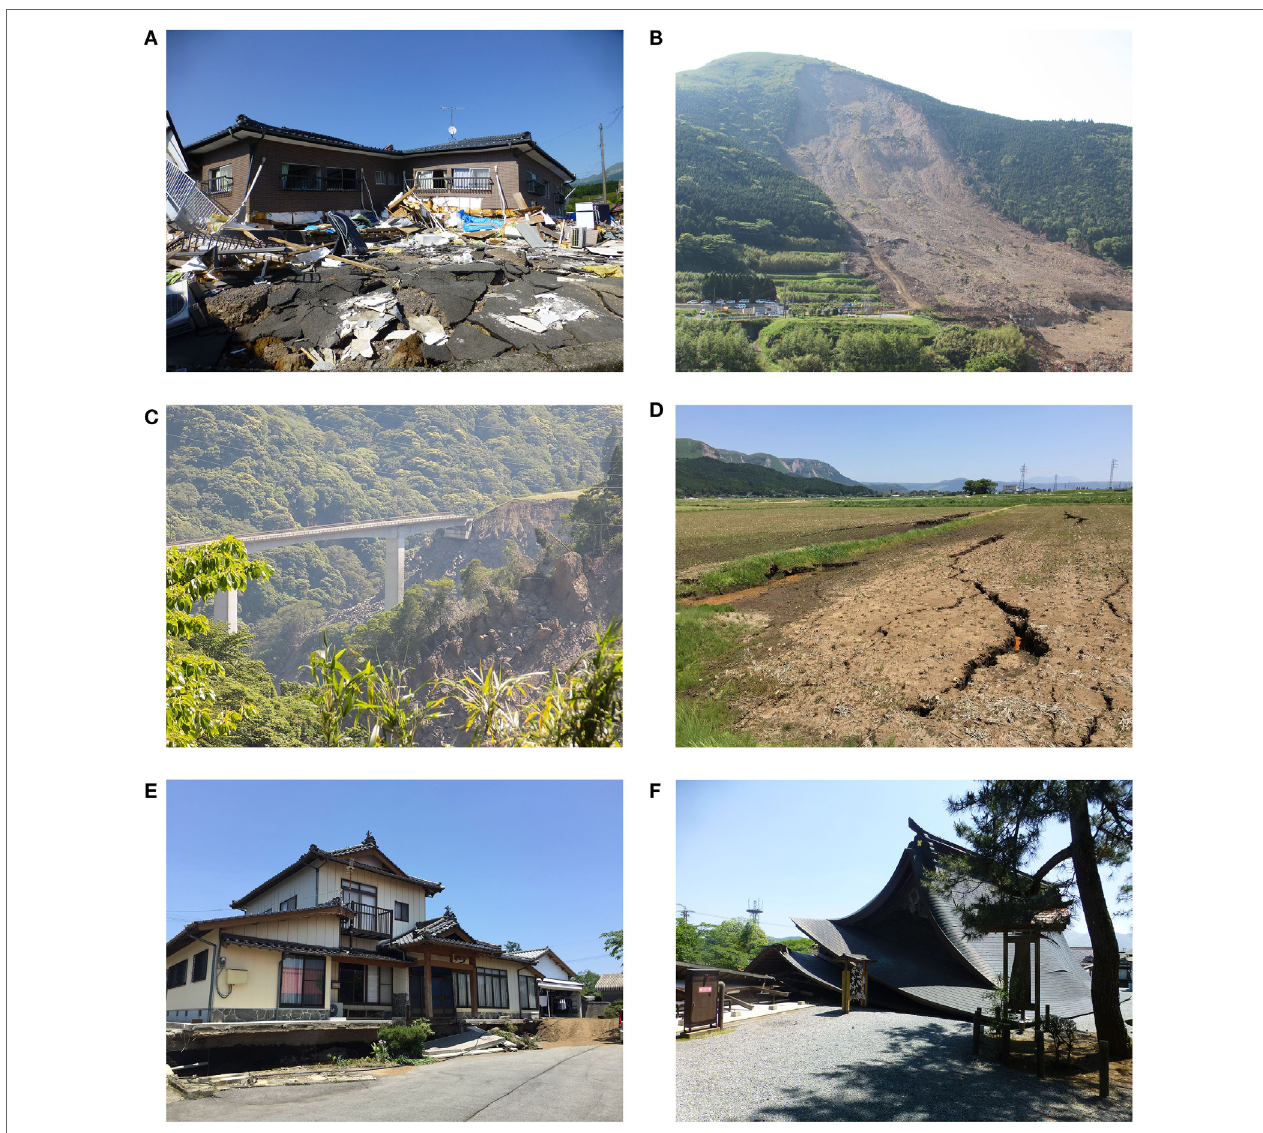
FigUre 17 | (a) Collapsed timber building in the Kurokawa district of Minami Aso Village (Location 11 in Region 3). (B) Route 57 blockage due to the landslide near Aso bridge (location 11 in Region 3). (c) Damage to Choyo bridge (location 11 in Region 3). (D) Ground cracks near the Akamizu railway station (location 12 in region 3). (e) Ground settlement over a timber house (location 13 in region 3). (F) Collapse of Aso Shrine (location 14 in region